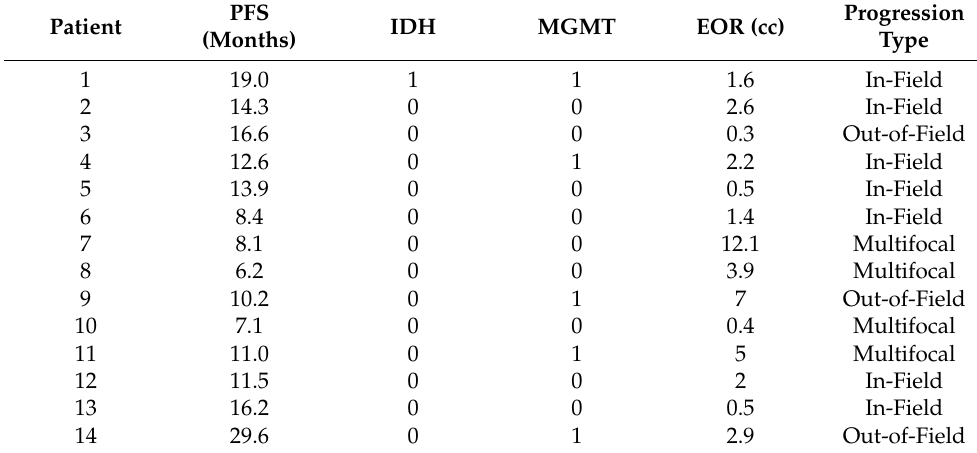
Table 1. Compiled genetic and PFS data for 14 of the 19 patients with confirmed tumor progres- sion .